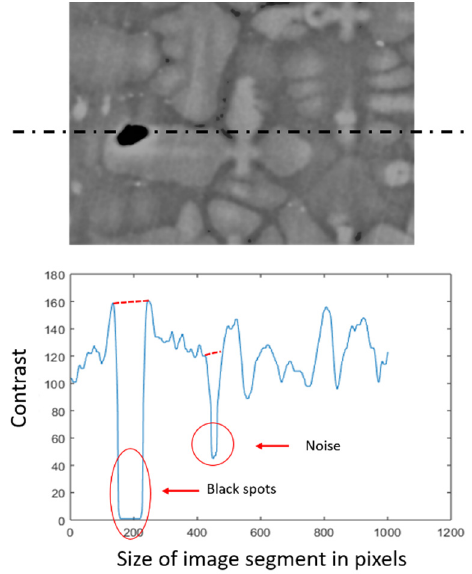
Figure 5. A contrast diagram across a line segment of an image section illustrating black spots and noise and the result of the smearing algorithm applied to those two features (in red).